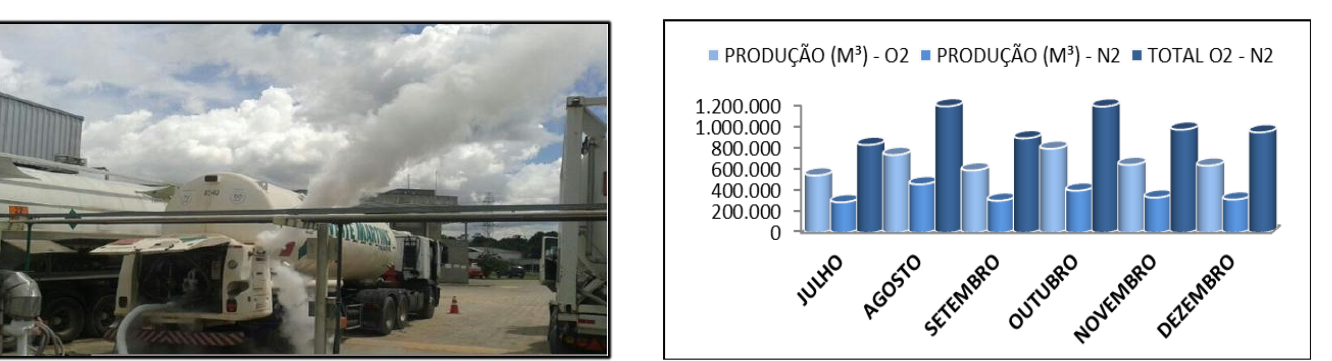
e N líquido (m³) - 1º semestre de 2013. 2 2